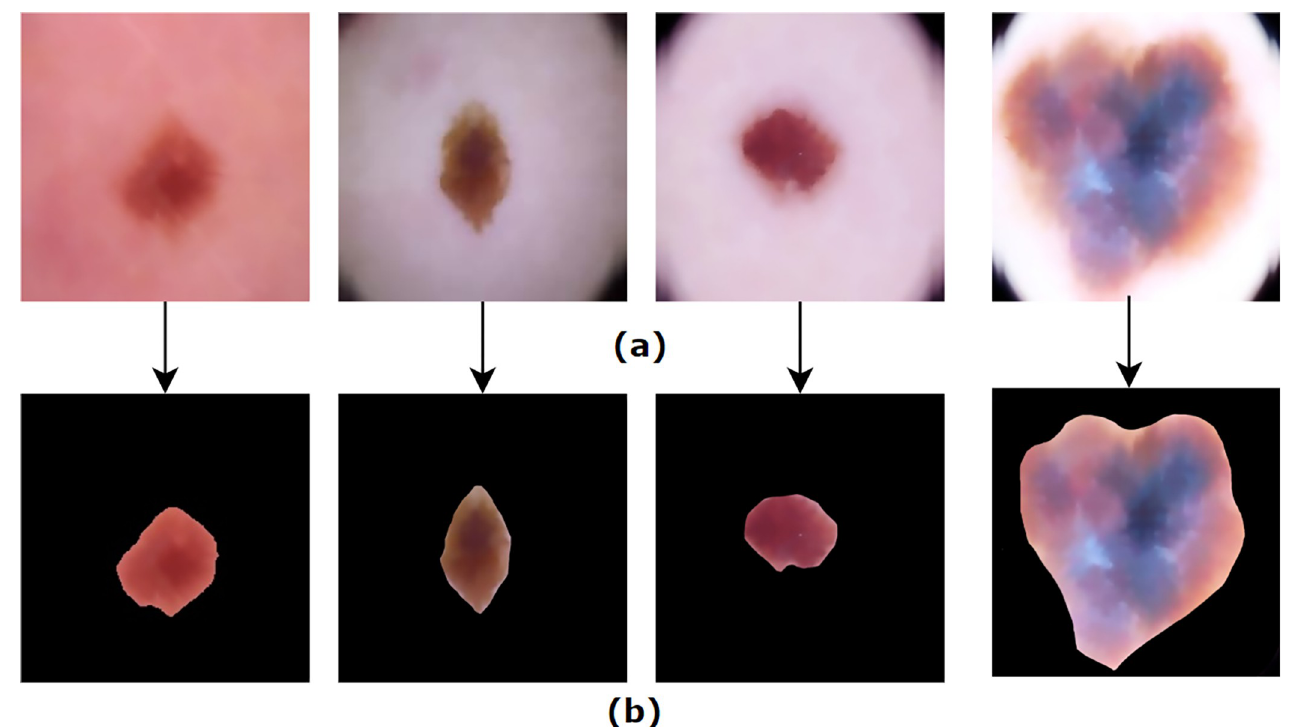
Fig 16. (a) Pre-processed images of skin lesion (b) Resultant images after ROI extraction.